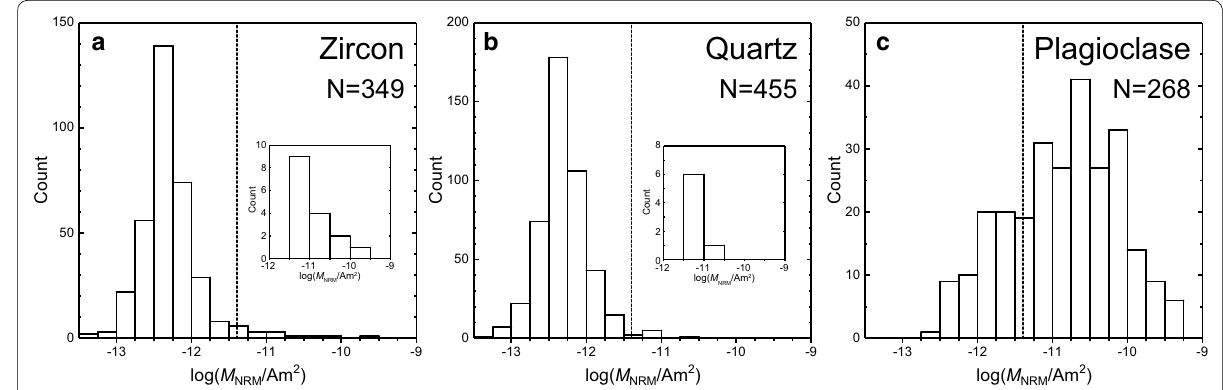
Fig. 3 Histogram of NRM intensity of a zircon, b quartz and c plagioclase. Dotted lines indicate the threshold for significant remanence. Inset figures in a and b show the histogram of NRM intensity above the threshold (4